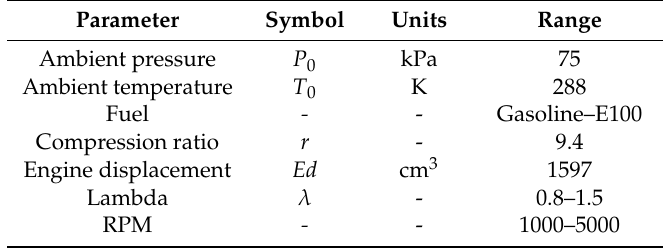
Table 2. Input data for estimating fuel consumption and mass emissions of air pollutants. Parameter Symbol